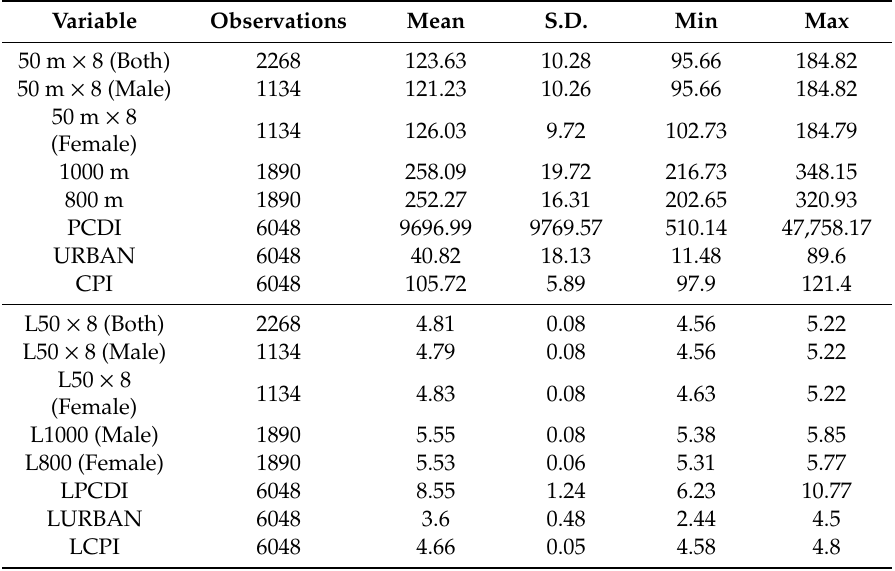
Table 2. Summary Statistics of all